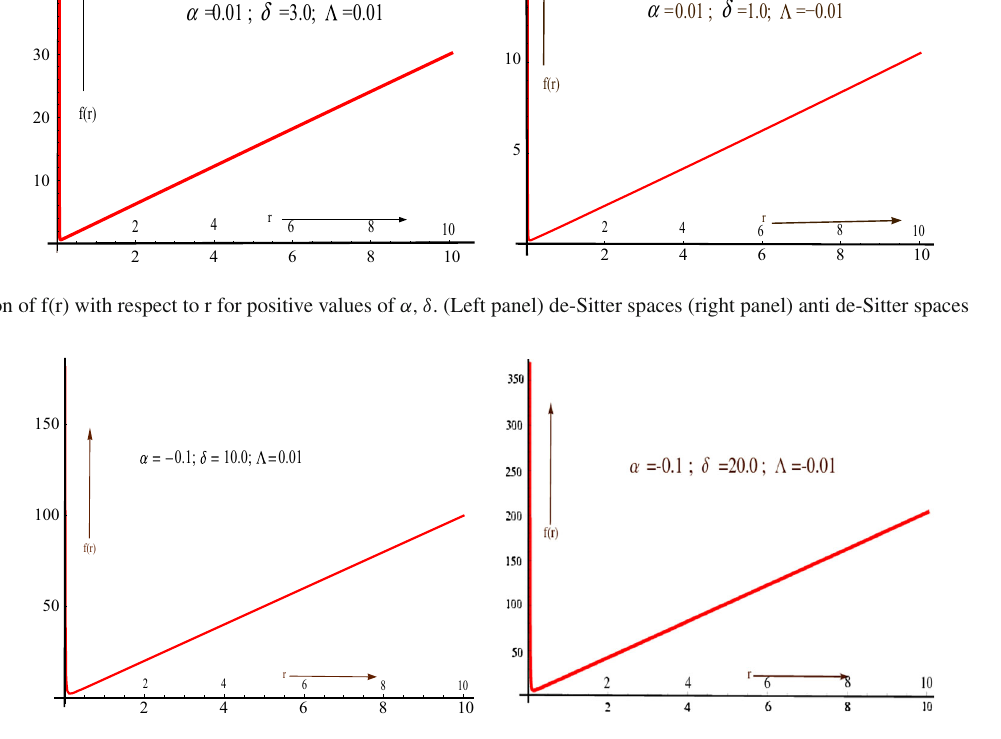
Fig. 2 Variation of f(r) with respect to r for negative values of α and positive values of δ . (Left panel) de-Sitter spaces (right panel) anti de-Sitter